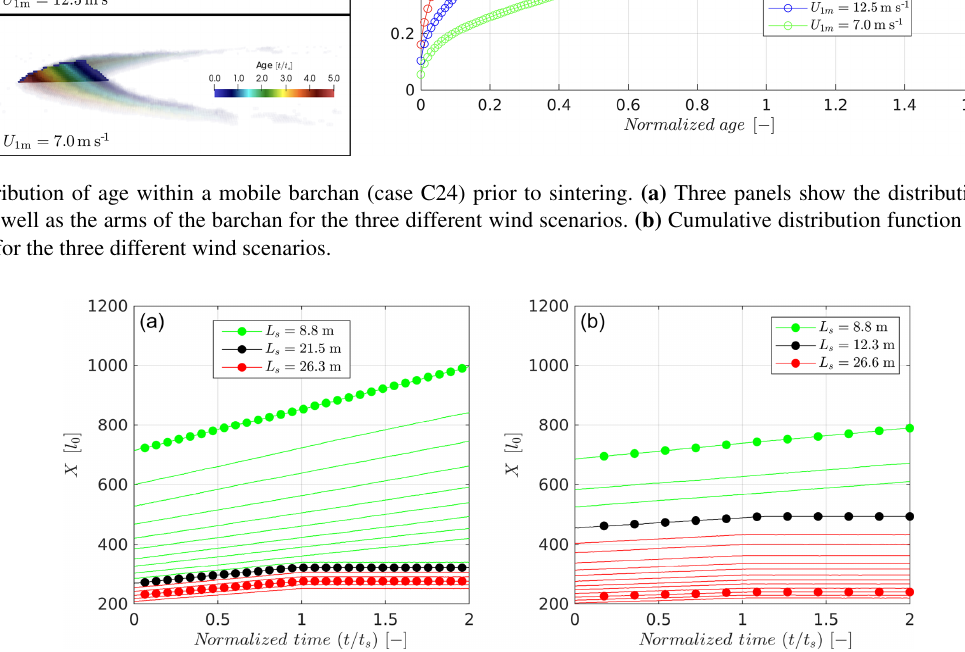
Figure 8. Identification of the maximum streamwise length (MSL, L s ) for (a) high-wind and (b) medium-wind scenarios. In each figure, the location of the tail of the barchan is plotted as a function of time. Lines from top to bottom represent barchans with increasing size. The lines are coloured to identify mobile (green) and immobilized (red) behaviours. The black line identifies the barchan at which this transition